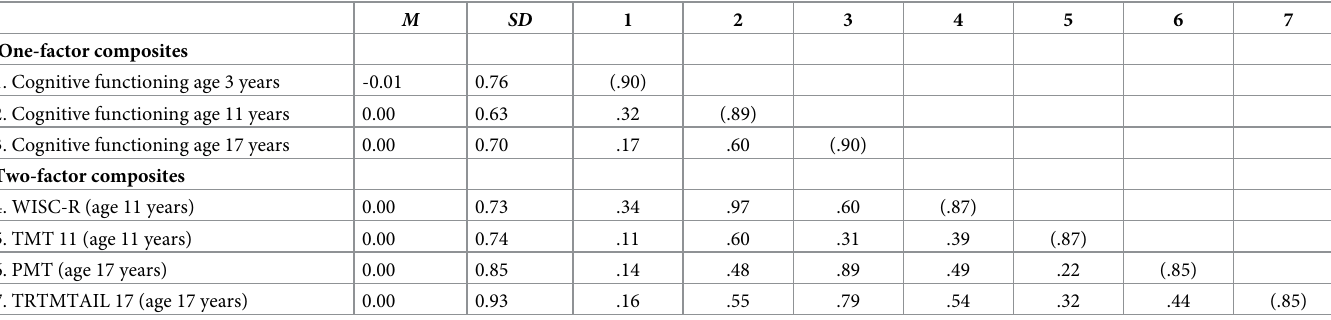
Table 2. Zero-order correlations and internal consistency estimates ( ω ) for cognitive functioning composites for ages 3, 11, and 17 years for the imputed data. M